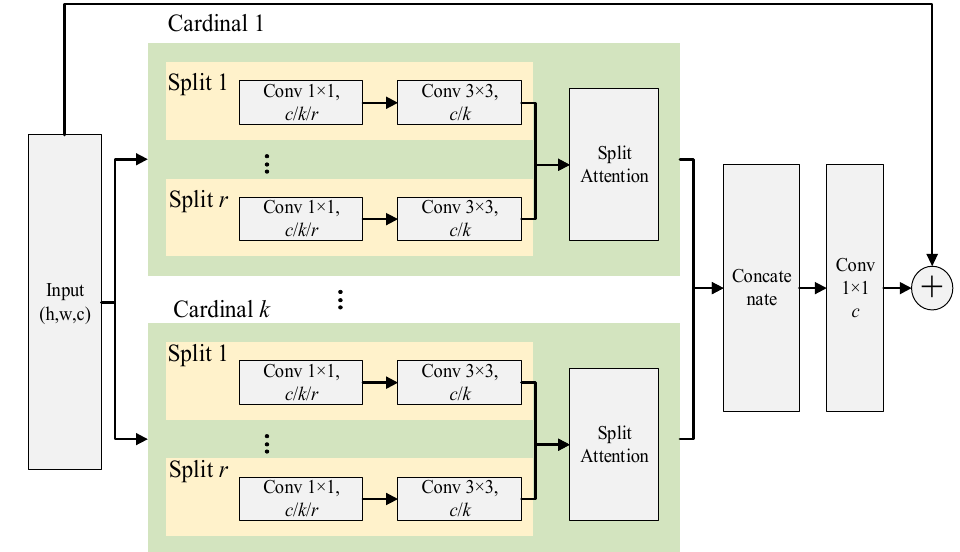
Figure 2. ResNeSt block [32] © 2022 IEEE.